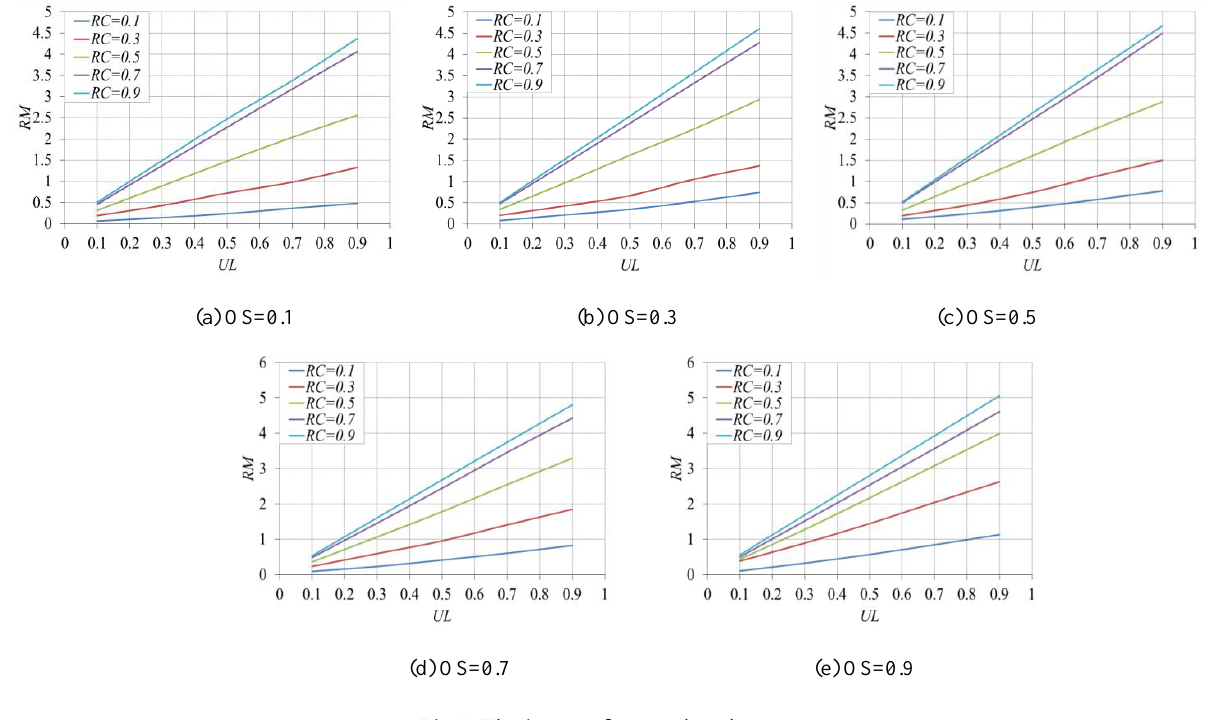
Fig.11 The impact of UL on the